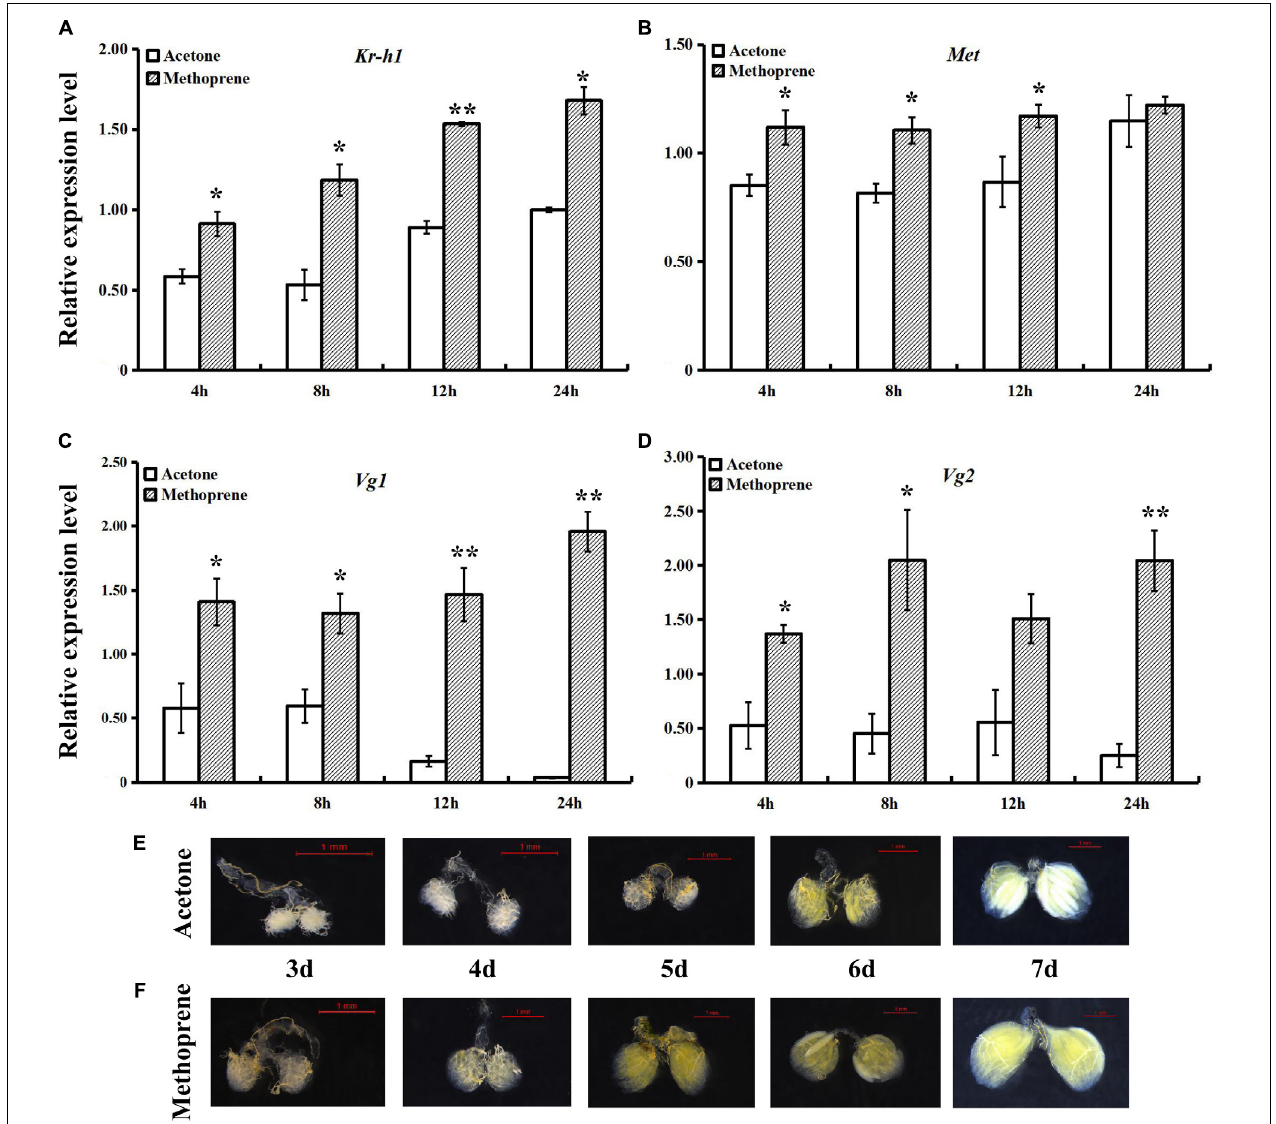
FIGURE 3 | Effects of methoprene on expressions of JH signaling and Vg genes and ovary progress. Transcript levels of BdKr-h1 (A) , BdMet (B) , BdVg1 (C) , and BdVg2 (D) upon methoprene treatment. Three replicates were conducted and the data were presented as mean ± SE. Significant differences between treatment and control were indicated with asterisks ( ∗ P < 0.05, ∗∗ P < 0.01). (E) Ovary progress after acetone treatment and (F) methoprene treatment.